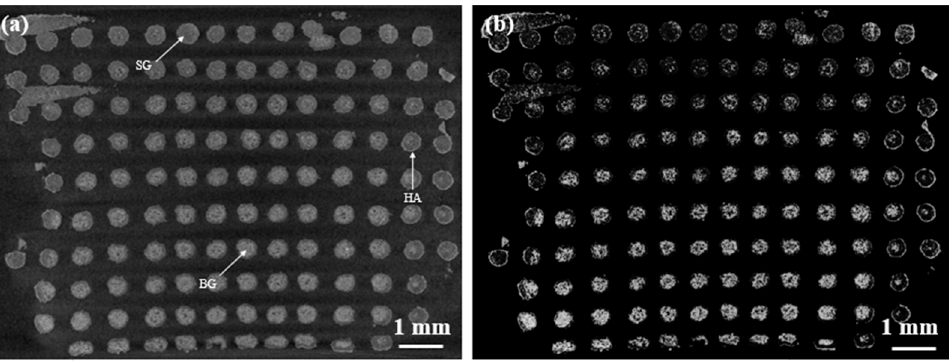
Figure 8. µCT cross-sections of the scaffold after 2-week SBF immersion: ( a ) standard visualization; Figure 8. µ CT cross-sections of the sca ff old after 2-week SBF immersion: ( a ) standard visualization; ( b ) enhanced contrast. Different phases and reaction layers are highlighted: BG, unmodified 47.5B ( b ) enhanced contrast. Di ff erent phases and reaction layers are highlighted: BG, unmodified 47.5B glass; SG, silica gel layer; HA, newly-formed hydroxyapatite. glass; SG, silica gel layer; HA, newly-formed